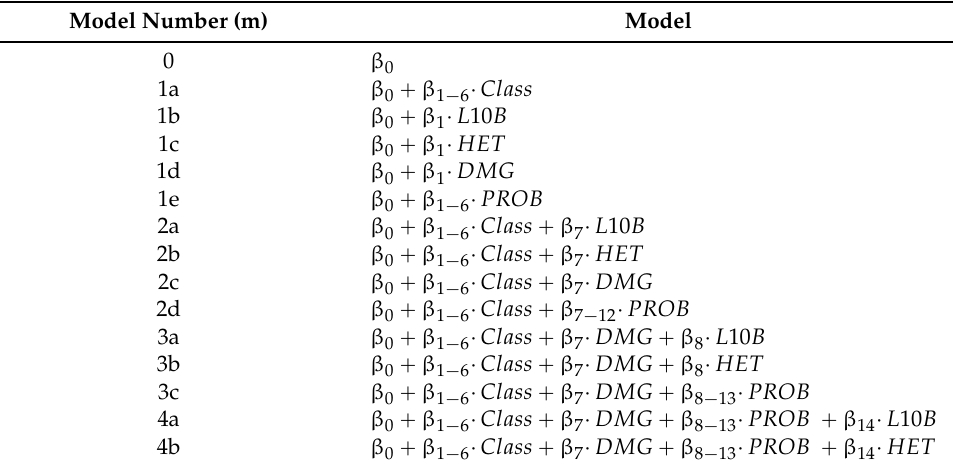
Table 3. Description of models.